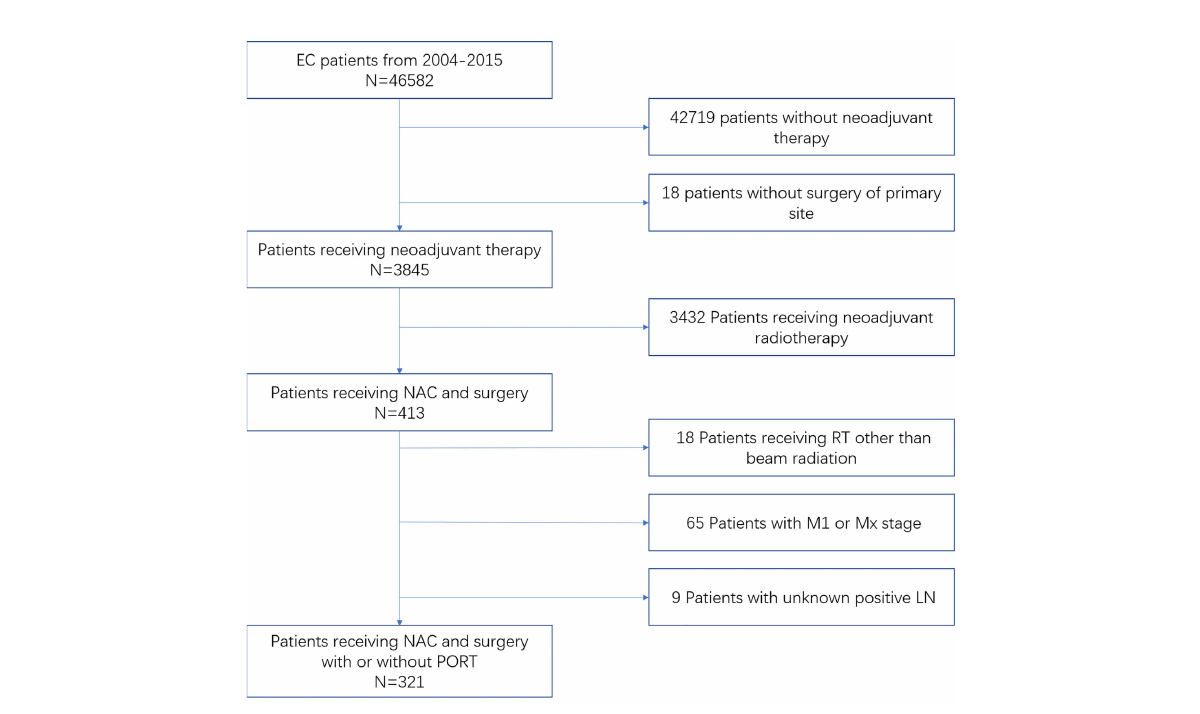
FIGURE 1 Inclusion and exclusion fl ow diagram for SEER EC patients receiving NAC followed by surgery with or without PORT from 2004 to